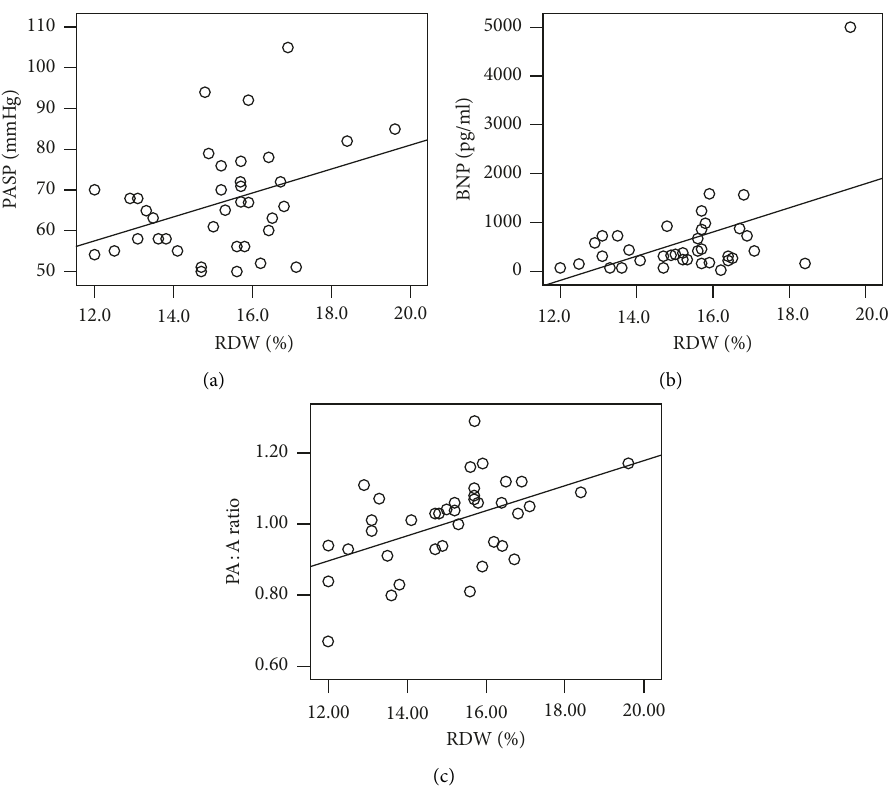
Figure 2: (a–c) Correlations of RDW levels with PASP, BNP, and PA :A. (a) RDW vs. PASP, r � 0.390, R 2 � 0.152, p � 0 . 014; (b) RDW vs. BNP, r � 0.513, R 2 � 0.263, p < 0 . 001; (c) RDW vs. PA: A, r � 0.502, R 2 � 0.270, p < 0 . 001. RDW, red blood cell distribution width; PASP, pulmonary artery systolic pressure; PA : A, pulmonary artery-to-ascending aorta ratio; BNP, brain natriuretic